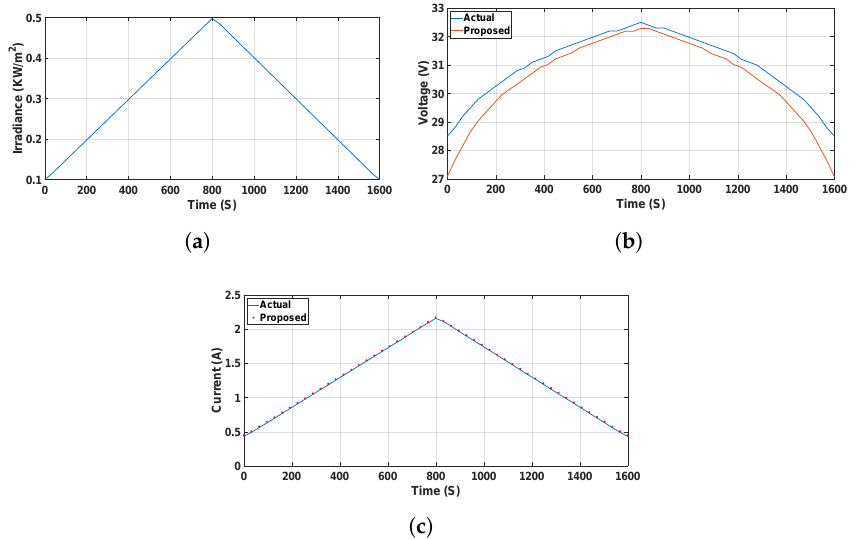
Figure 10. ( a ) Irradiance with gradient of 0.5 W/m 2 /s ( b ) accuracy of Proposed algorithm in finding V MPP at 0.5 W/m 2 /s gradient ( c ) accuracy of the Proposed algorithm in finding I MPP at 0.5 W/m 2 /s